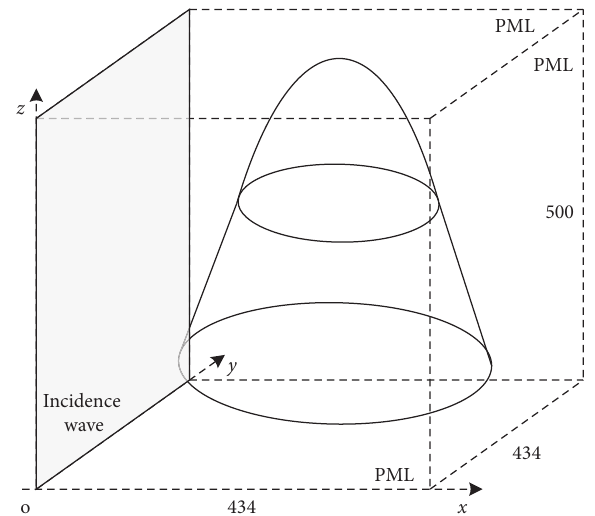
Figure 2: The sketch picture of the computational domain with the flight vehicle